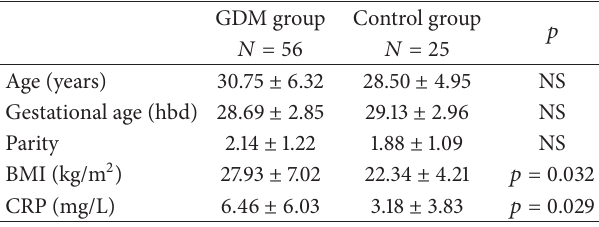
Table 1: Characteristics of group with GDM and control. GDM group Control group